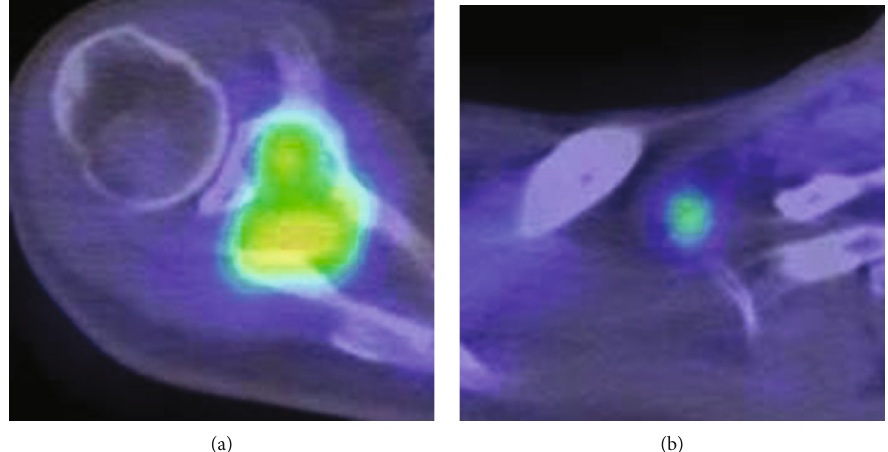
Figure 3: 18 F-FDG-PET/CT scan at fi rst presentation. PET/CT fusion image shows increased FDG uptake in (a) the scapular tumor (SUV